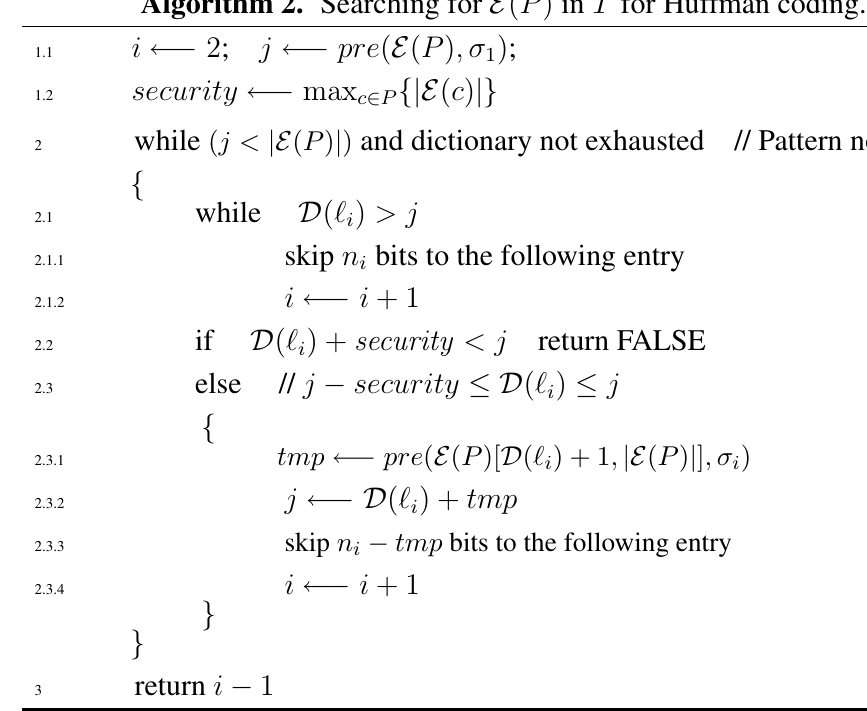
Algorithm 2. Searching for E ( P ) in T for Huffman